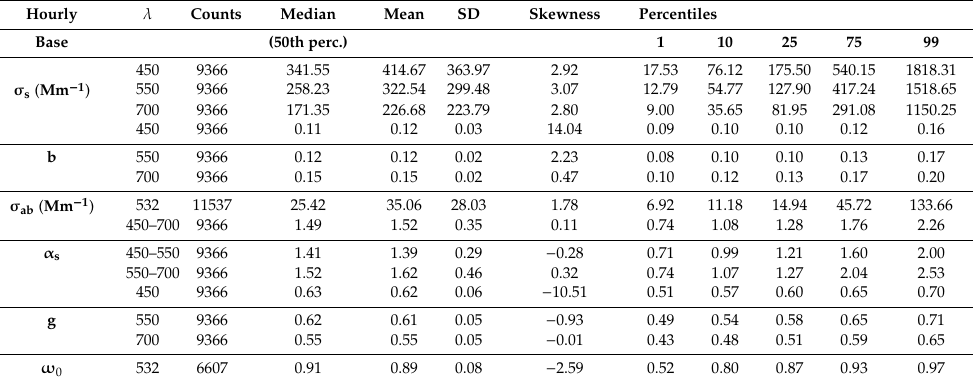
Table 1. Aerosol optical properties at LIESMARS site in Wuhan